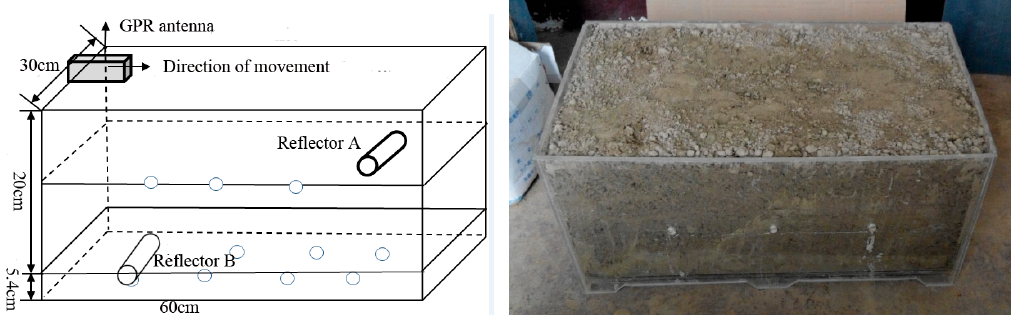
Figure 3. Structure of the artificial model box.